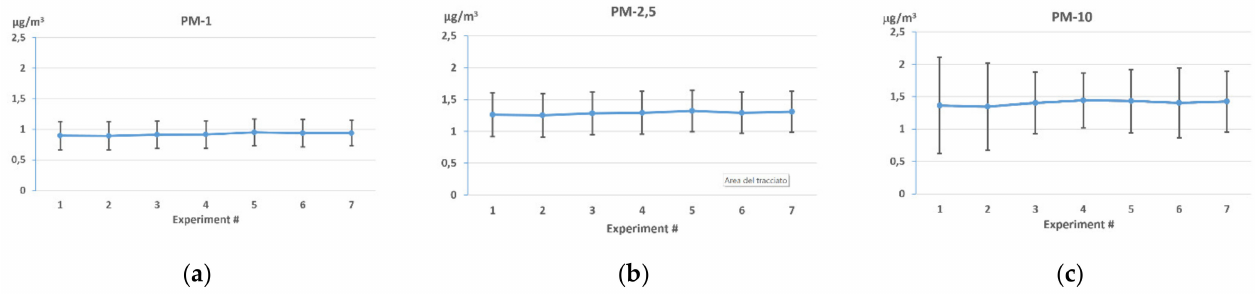
Figure 4. Stability measures in seven experiments (the error bars are standard deviations): ( a ) PM-1; ( b ) PM-2.5; ( c )